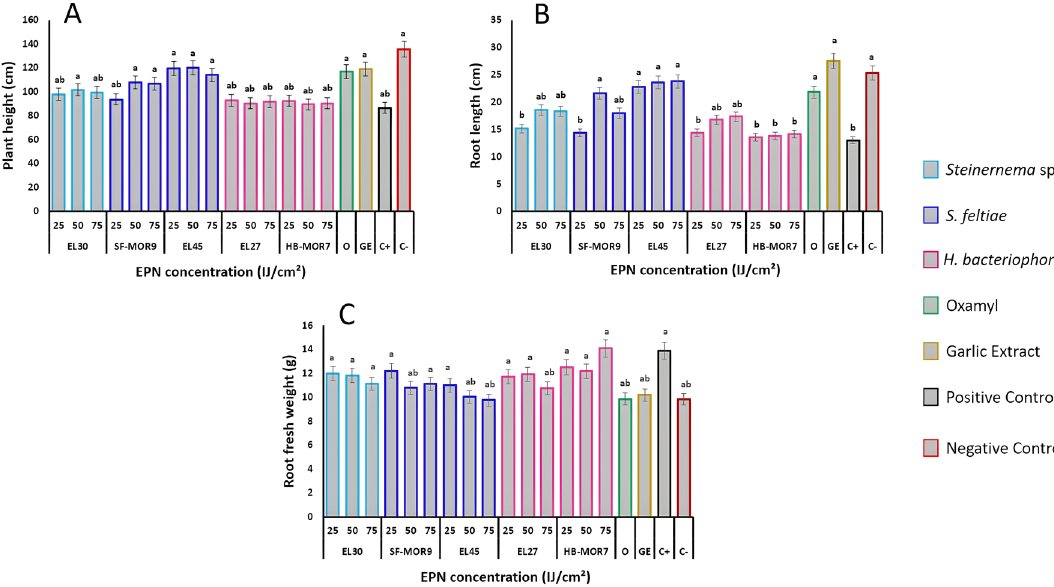
Figure 4. Effect of EPNs on plant growth parameters. ( A ) Plant height. ( B ) Root length. ( C ) Root fresh weight. Values represent the mean + standard error (SE); Letters represent homogeneous groups based on protected least significant difference test (LSD) for each variable at ( P <